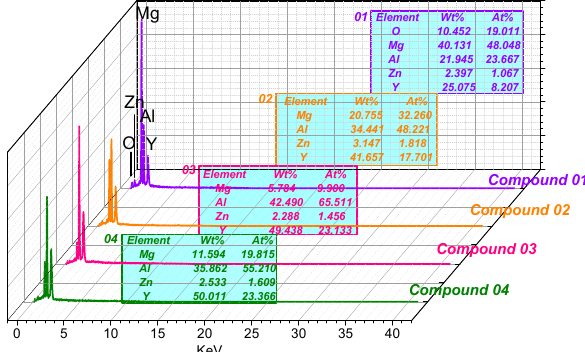
Figure 8. EDS results of Al 2 Y phase marked in Figure 7.